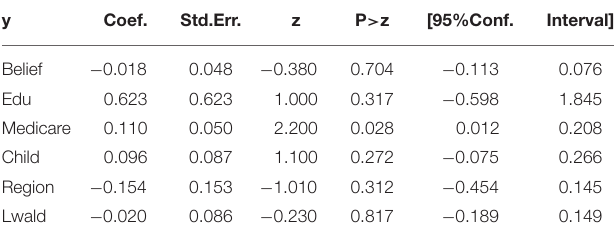
TABLE 5 | Continuity test of control variables.